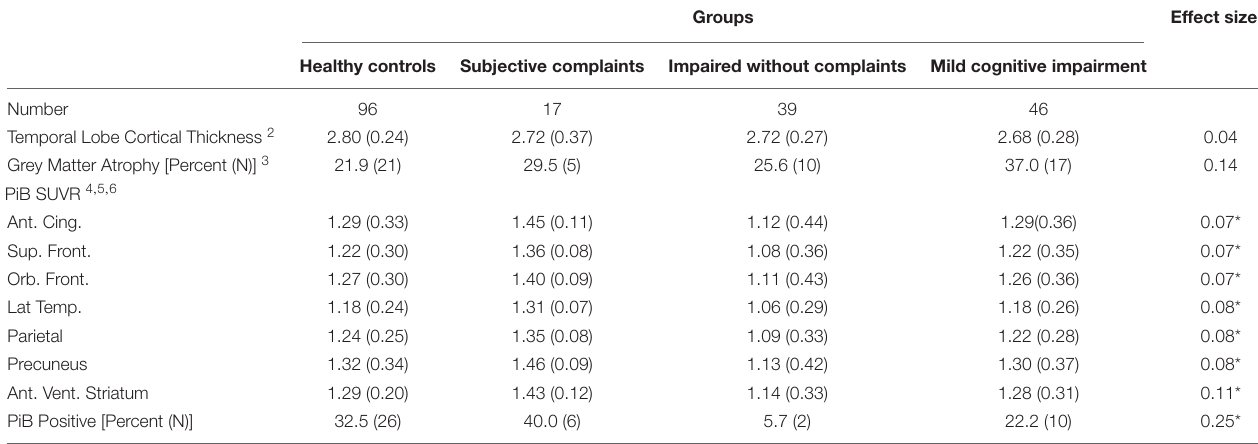
TABLE 4 | Summary neuroimaging findings among four subject groups.